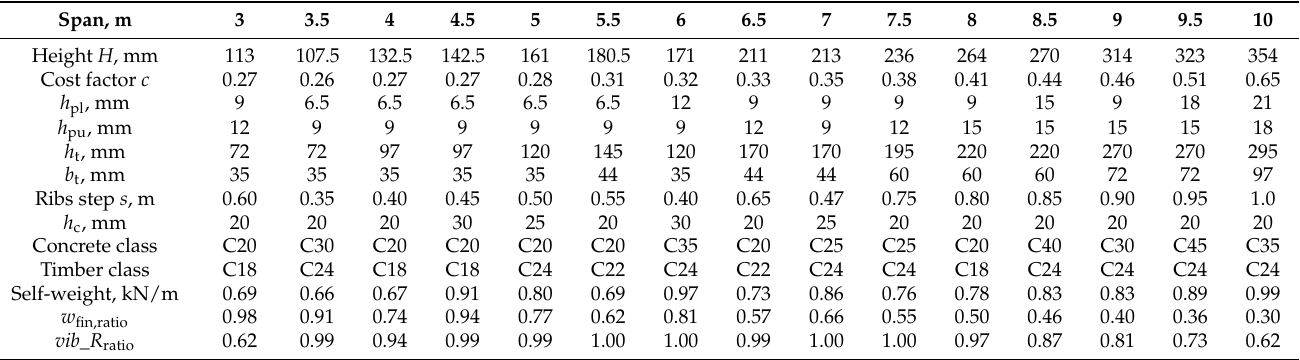
Table 7. The most rational cross-sectional parameters of the CLT–concrete composite panel for category A1.